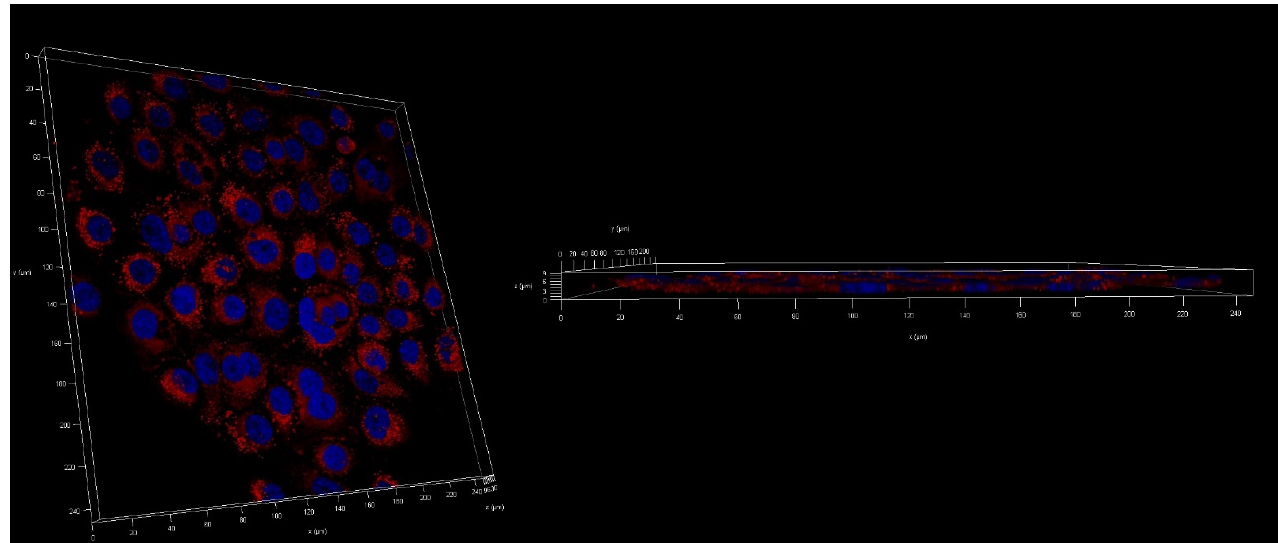
Figure 17. Z-stack analysis of the cellular uptake of Nile-Red-loaded UA-S85-PLGA-PEG 2000 na- noparticles by BxPC-3 pancreatic cell lines.